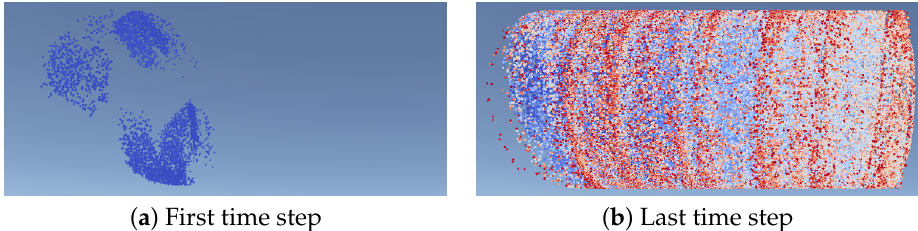
Figure 11. Results of a particle simulation in a decanter centrifuge, visualized using a polygon file fomat: ( a ) shows the first time step and ( b ) the last time step of the simulation. With each time step, the particles migrate further.